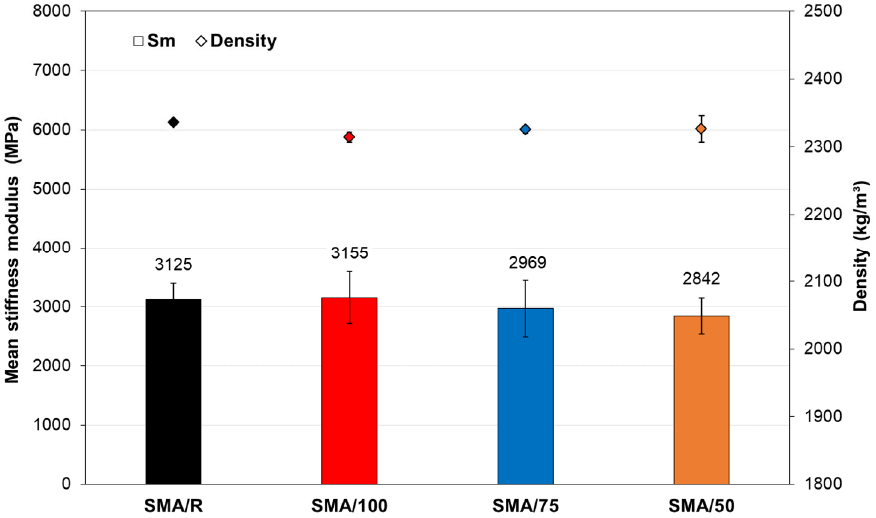
Figure 10. Stiffness modulus of the SMA mixtures studied at 20 °C.